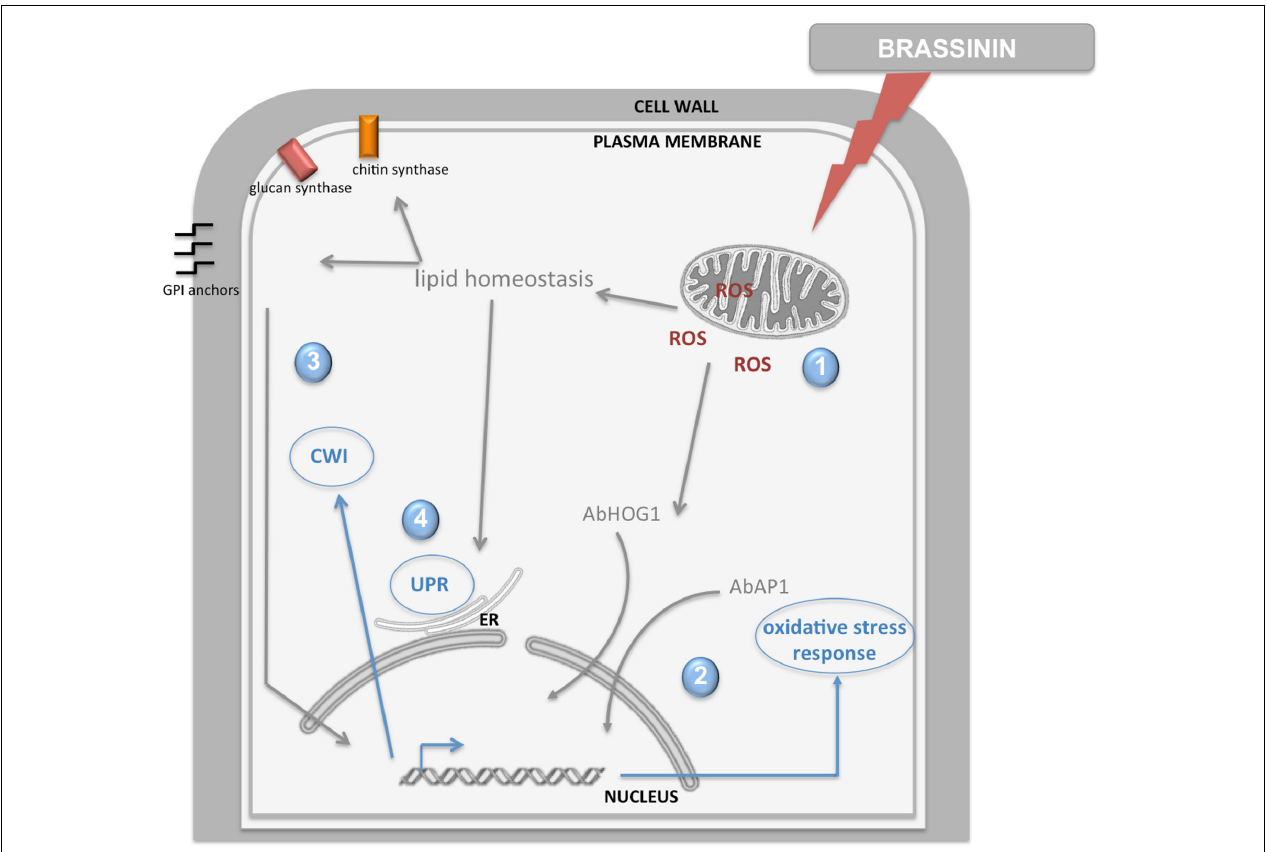
FIGURE 10 | Model illustration of the fungal response induced by brassinin. The indolic phytoalexin primarily targets mitochondrial functions in fungal cells, inducing secondary effects such as ROS production and alteration of lipid homeostasis (1). Then, ROS production elicits AbHOG1 and AbAP1-mediated responses in order to reinforce antioxidant defenses and limit their deleterious effects (2). Changes in lipid homeostasis affect the activity of cell wall synthesis enzymes located in the plasma membrane and synthesis of the GPI anchor, leading to activation of the cell wall integrity pathway (3). Perturbations in membrane and cell wall homeostasis trigger UPR induction